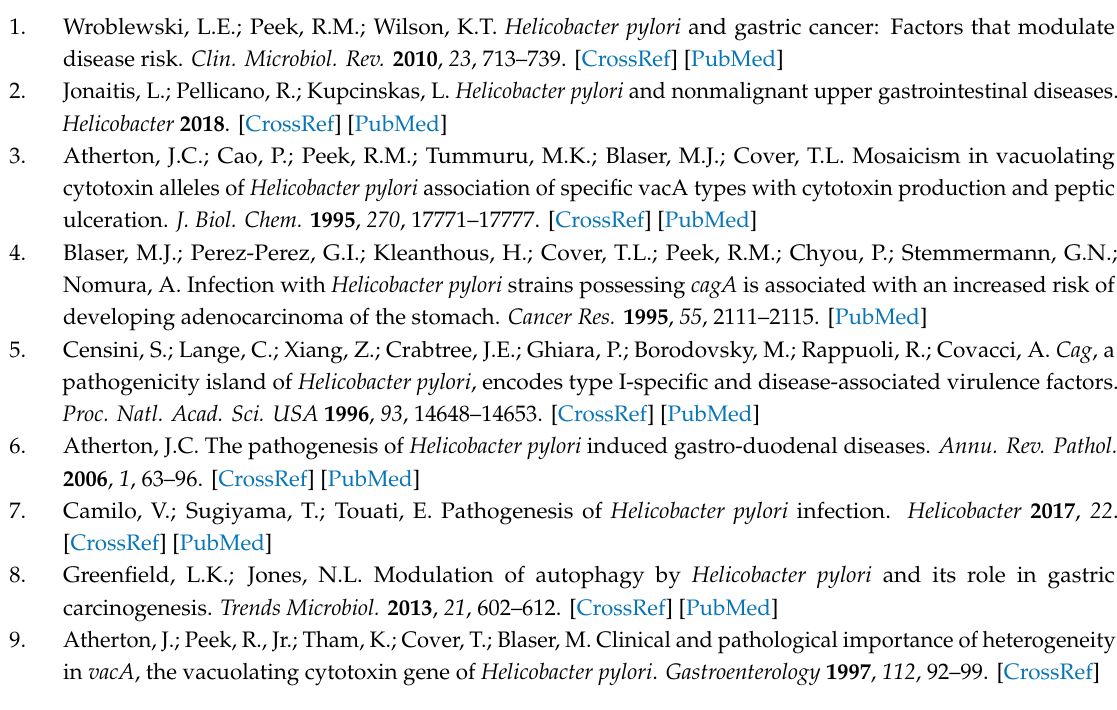
Table S1: Summary of demographic patient information, endoscopic data and overview of virulence factors and phenotypic antibiotic resistance information of the H. plori isolates; virulence factors: a grey background indicates the presence of a virulence gene or that the virulence gene is expressed (“status-on”); antibiotic resistance information: a red background indicates resistance of H. pylori to the respective antibiotic. MIC, minimum inhibitory concentration, Table S2: Gene sequences derived from H. pylori strains available in the NCBI database used to detect the presence and variants of di ff erent virulence genes in the 41 H. pylori strains isolated from non-atrophic gastritis patients, Table S3: Association between the presence of cagA and vacA alleles and clarithromycin resistance, Table S4: Association between the abundance of Helicobacter pylori in the gastric mucosa and the expression of outer membrane proteins, Table S5: Association between the grade of gastritis and the expression of outer membrane proteins in Helicobacter pylori